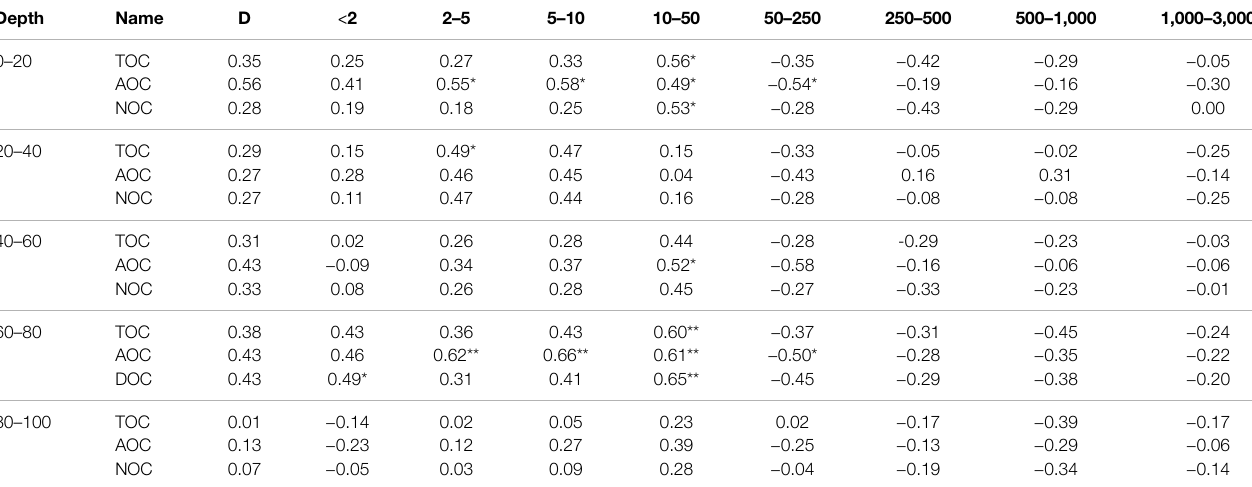
TABLE 7 | Correlation analysis between the soil particles and SOC in the woodland in the fl ooded area.